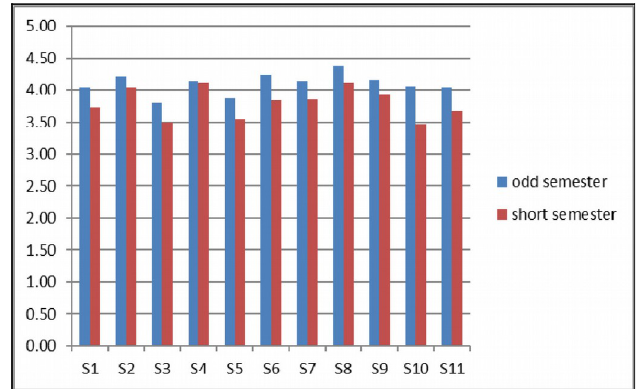
Figure 7. Mean scores of S1 to S11